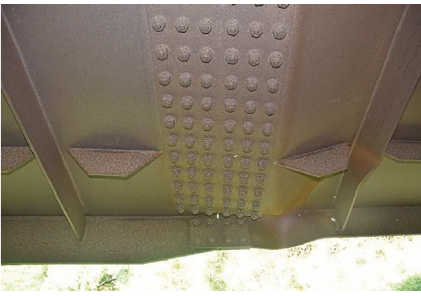
Figure 21: Deformation of girder